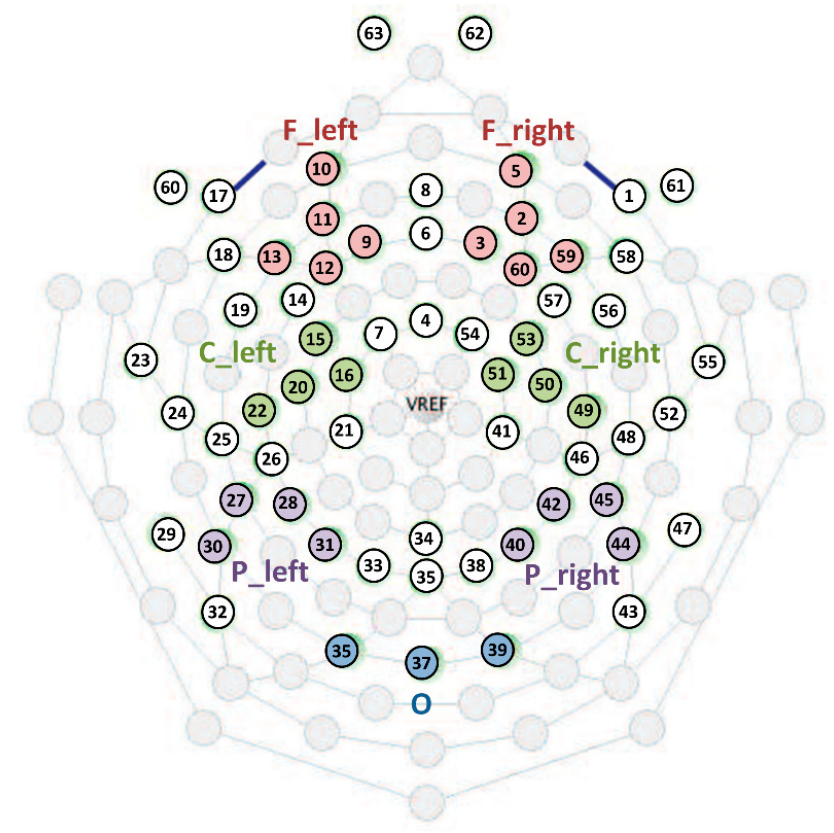
Figure 2. Sensor layout and representation of the created clusters of electrodes.